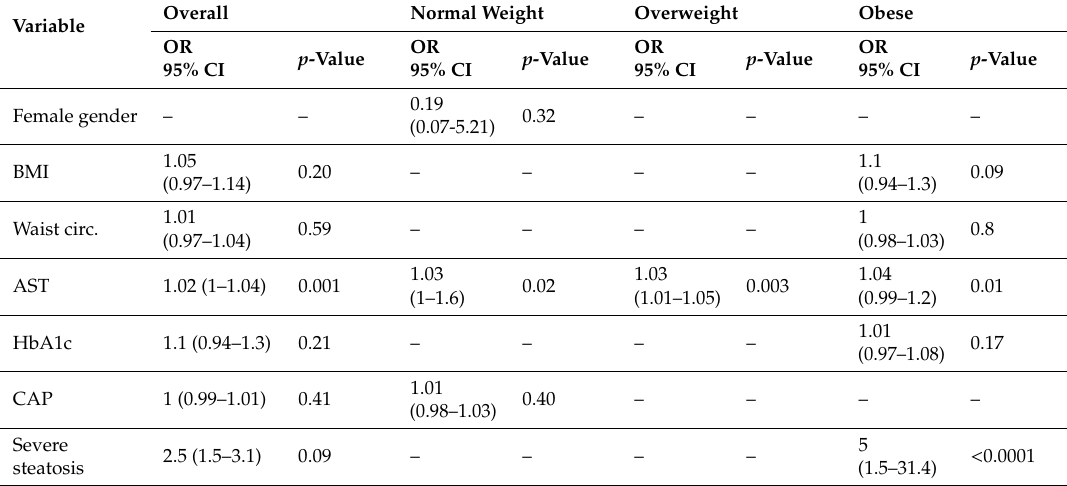
Table 6. Multivariate analysis of factors associated with advanced fibrosis.